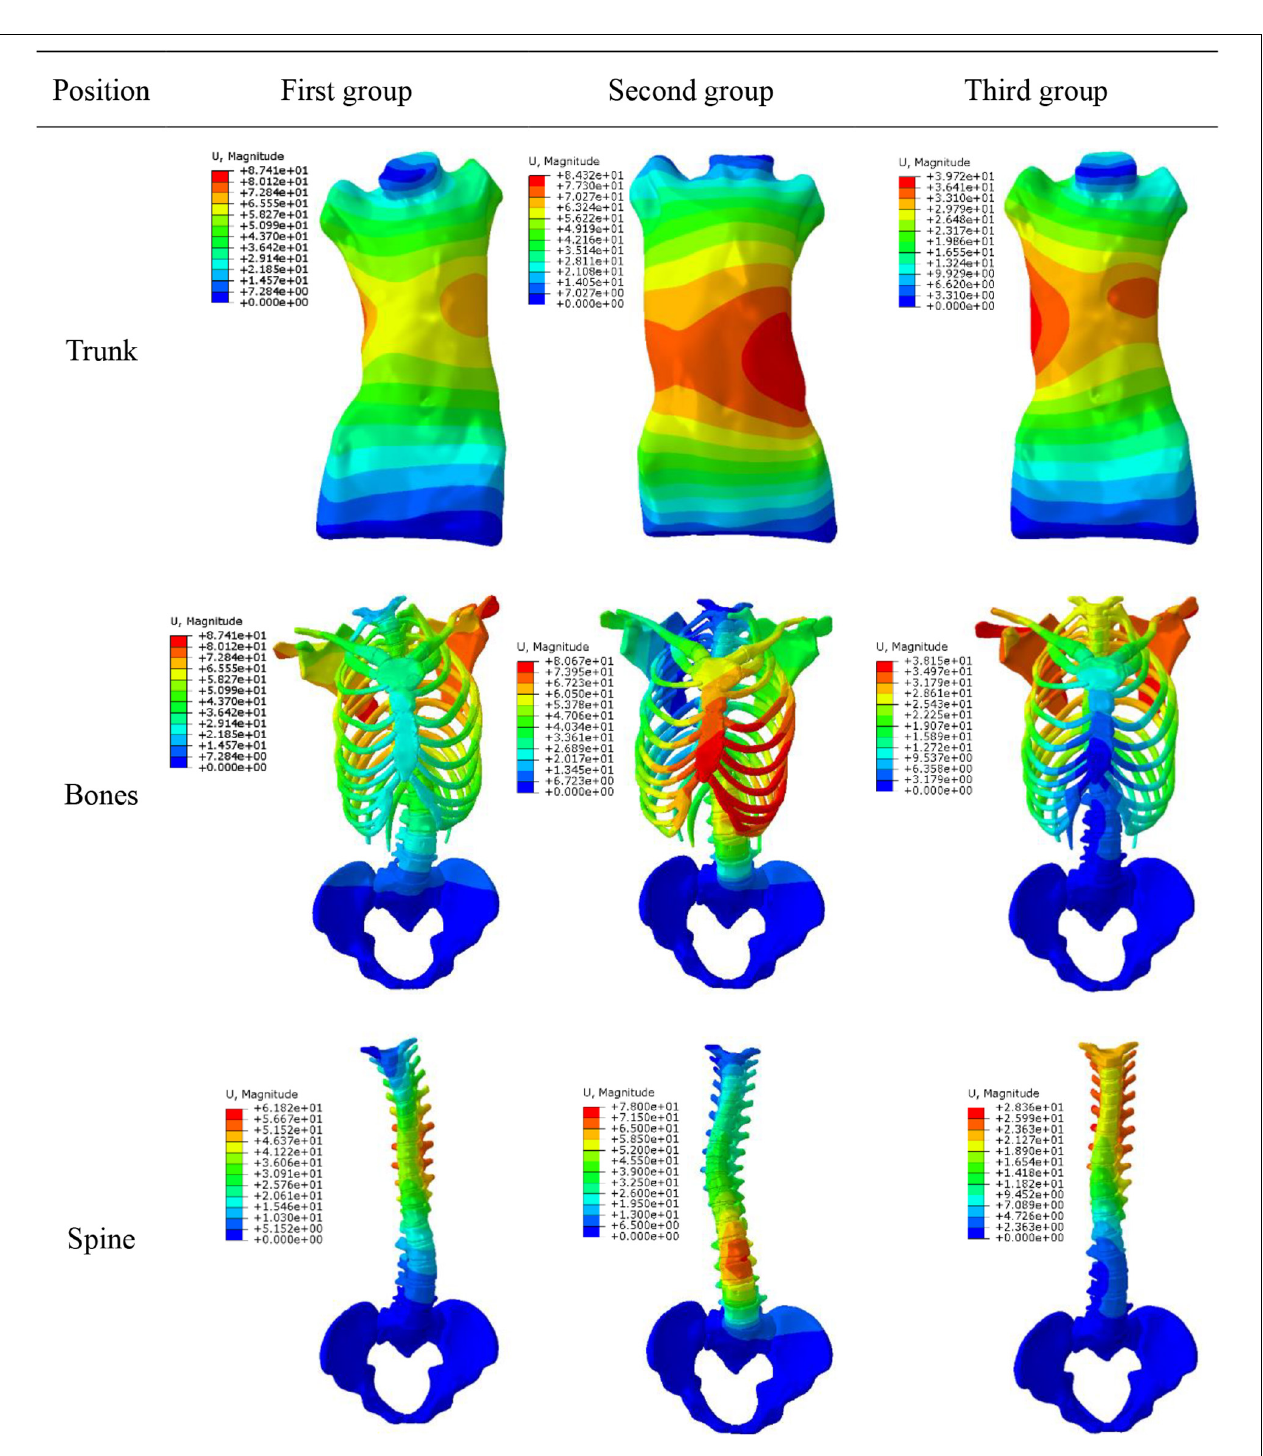
FIGURE 7 | Displacement variables.